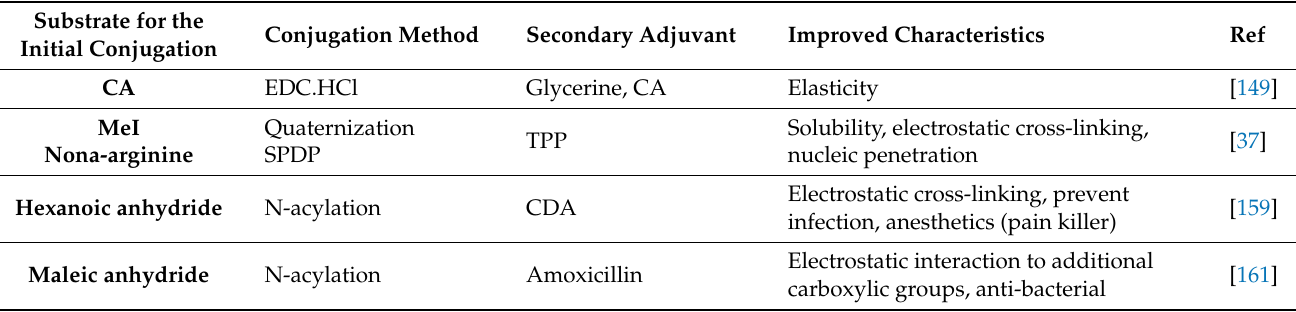
Table 4. Selected examples of CS-based materials involving small molecular